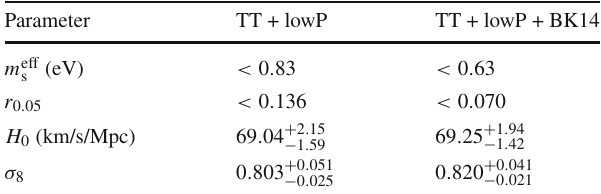
Table 5 Bounds on a cosmological parameters in the (cid:2) CDM + r 0 . 05 + m eff s model with N eff = 3 . 5, assuming partial thermalization of sterile neutrinos. Marginalized limits are given at 68% C.L. whereas upper limits are given at 95% C.L. Note that H 0 and σ 8 are derived parameters TT +